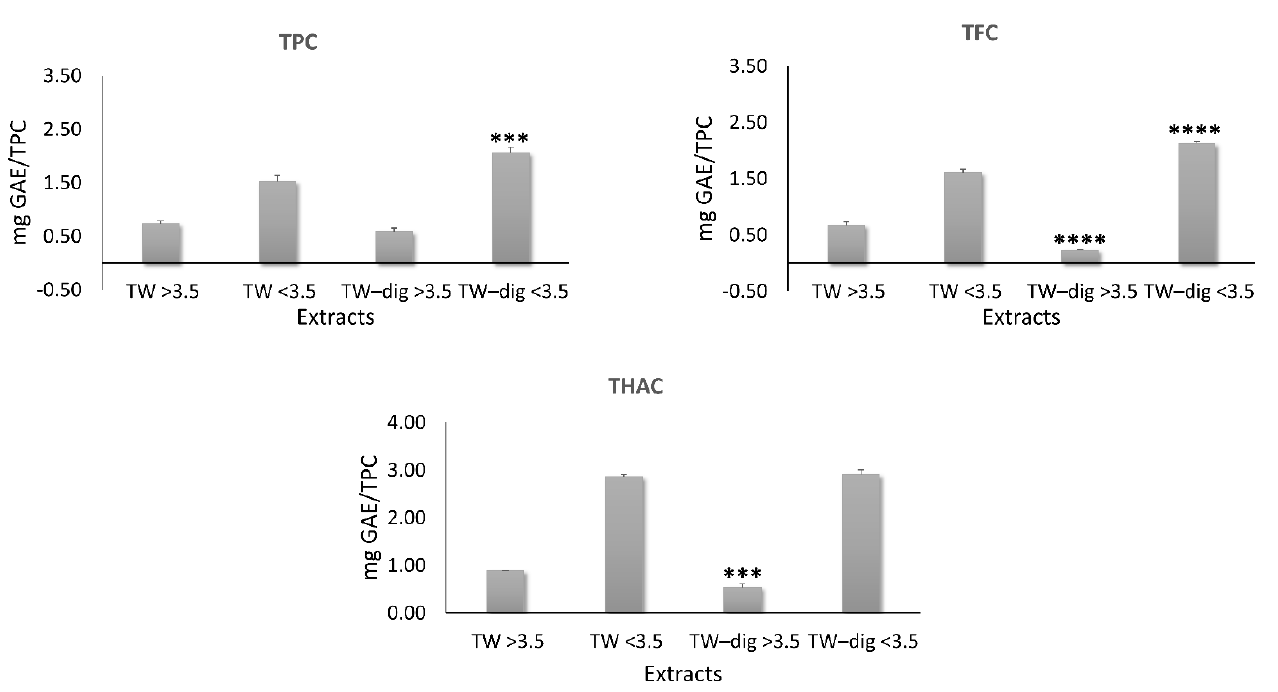
Figure 4. Normalized total phenol content (TPC), total flavonoid content (TFC), and total hydroxycinnamic acid content (THAC) of high and low mw fractions of the aqueous extract by the TPC of the corresponding extracts. Significant differences between digested and undigested extracts are denoted by symbols: *** p < 0.001 and **** p < 0.0001. Table 2. Phenolic compounds identified in TE (A) and TW (B) before and after digestion using HPLC–MS/MS in the negative ionization mode.